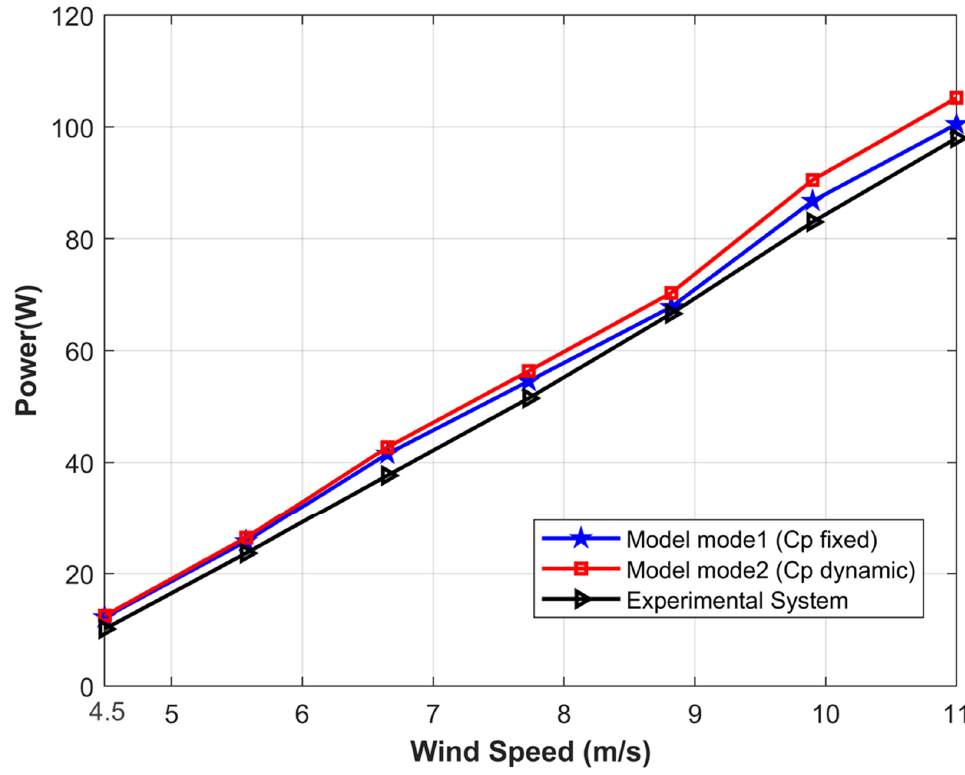
Figure 7. Comparison between the model results and measured data from the experimental setup in this study.